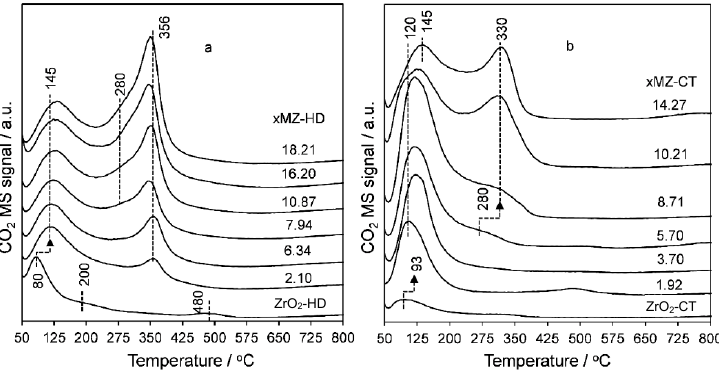
Figure 5. CO 2 -temperature-programmed desorption (TPD) profiles of: ( a ) xMZ–HD; and ( b ) xMZ–CT mixed